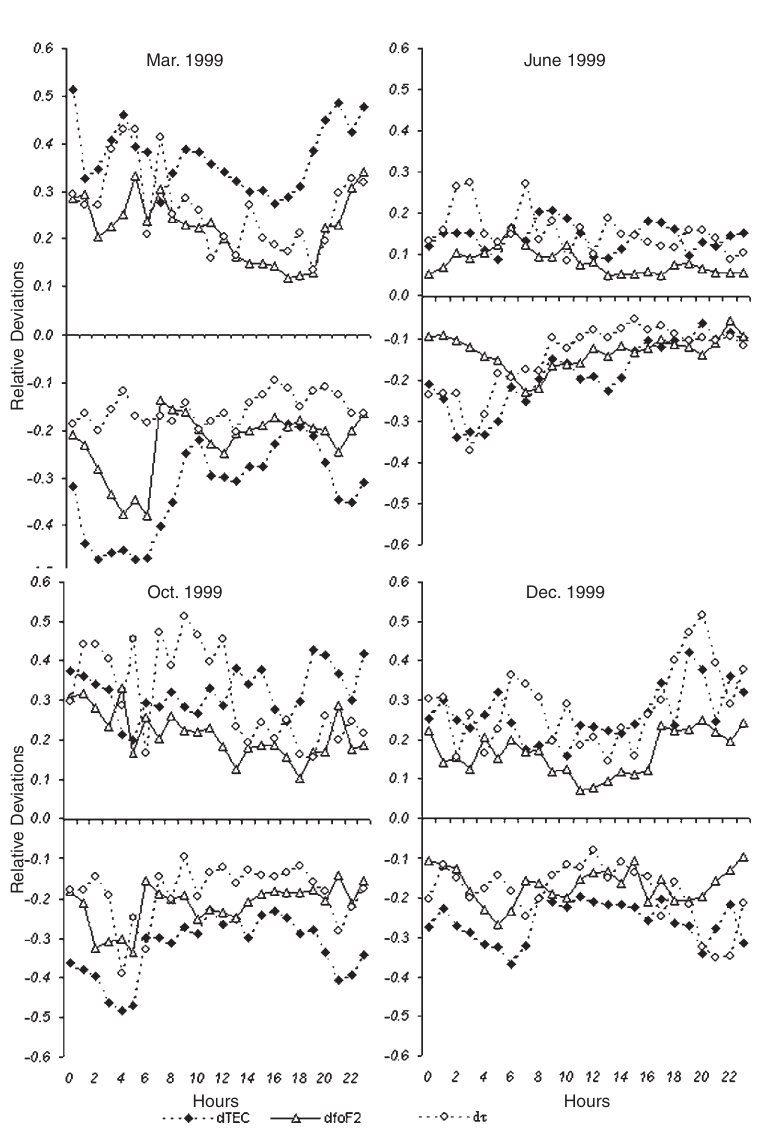
Fig. 8. Comparison of the Day-to-Day variability (Deciles) in TEC, foF 2 and τ at different months in